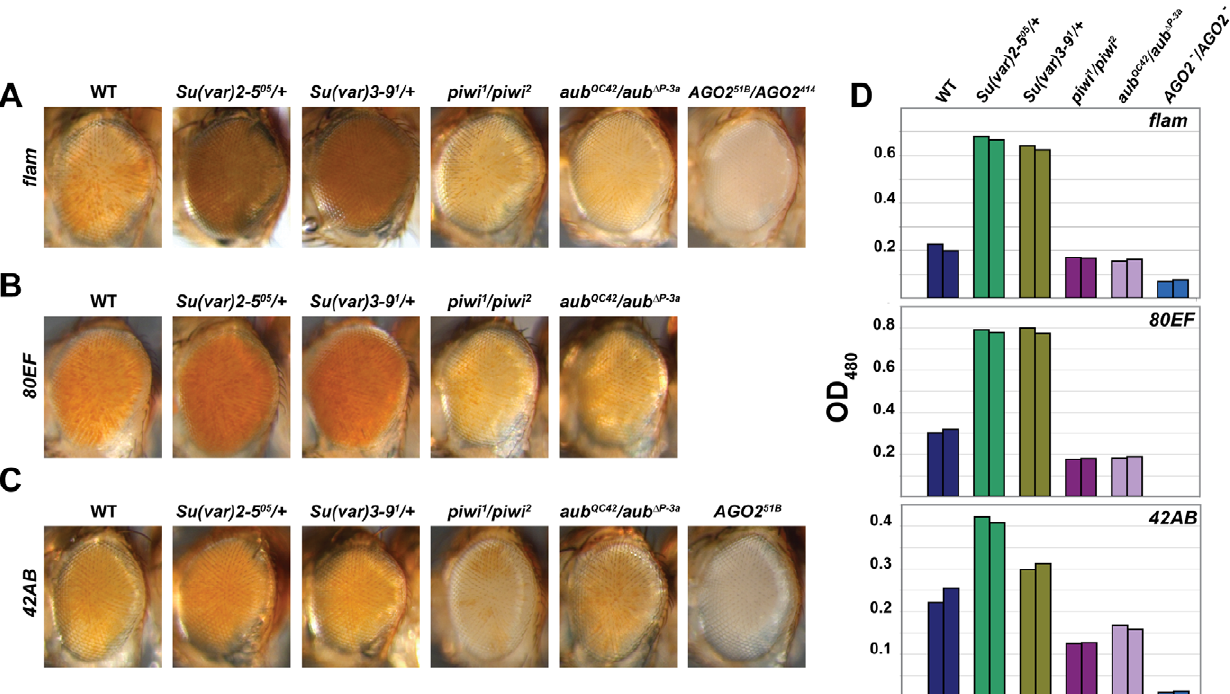
Figure 2. piRNA and endo-siRNA pathway mutants display increased silencing of transcriptional reporters at or near piRNA clusters. Adult eyes of wild type, Su(var)2-5 05 / + , Su(var)3-9 1 / + , piwi 1 /piwi 2 , aub QC42 /aub D P-3a , and/or AGO2 - / AGO2 - mutants carrying a mini-white transgene inserted inside or in close proximity to the (A) flam , (B) 80EF , and (C) 42AB piRNA clusters. AGO2 51B / AGO2 414 mutants are examined in (A) while AGO2 51B mutants are examined in (C). (D) Levels of eye pigment measured at 480 nm extracted from male heads of the indicated genotypes